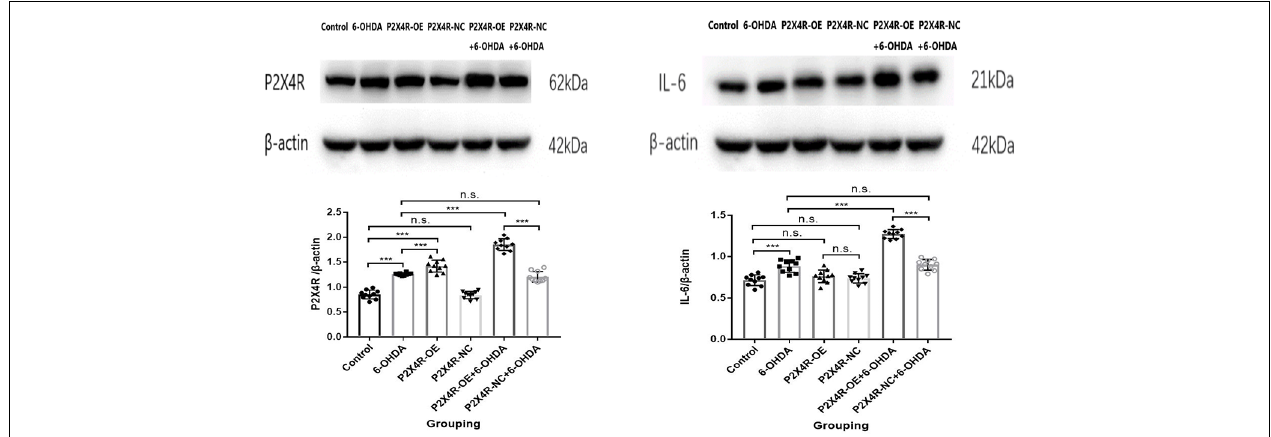
FIGURE 2 | The representative bands and western blot analysis of P2X4R and IL-6 in the substantia nigra (SN; n = 10). *** P < 0.001; n.s.: there is no statistical difference between the two groups.